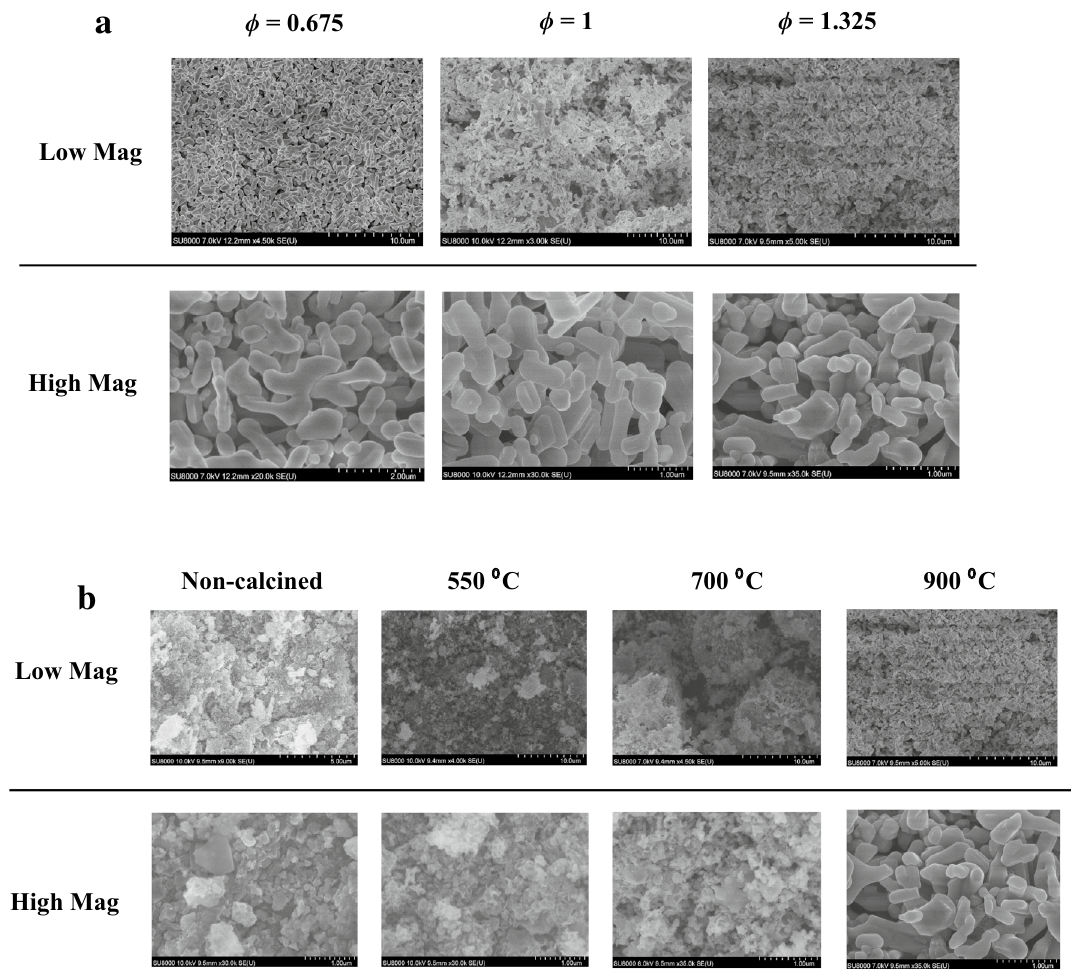
Figure 3. FESEM images of pCFO at low magnification (× 3–9 k) and high magnification (× 20–35 k): ( a ) images of pCFO synthesized at increasing ϕ and calcined at 900 °C, ( b ) images of pCFO synthesized at ϕ = 1.325 and calcined at different